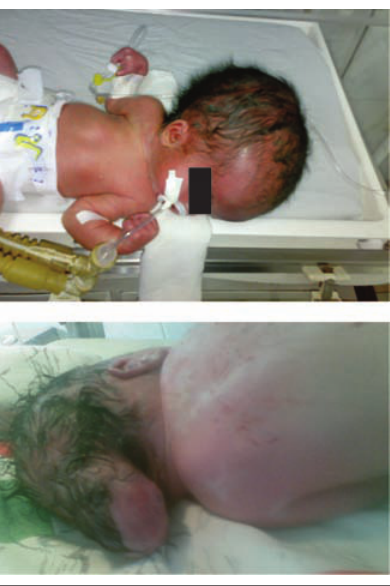
Figure 1. Congenital hydrocephalus, hand anomalies,